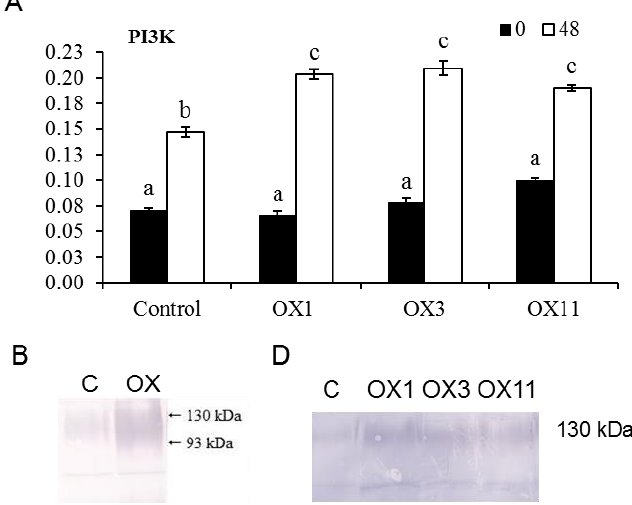
Figure 3. Panel A : Quantitative Realtime PCR analysis of transcript levels of phosphatidylinositol 3- 3-kinase in flowers (stage 5) of control (C) and transgenic PI3K (OX1, OX3 and OX11) N. tabacum lines. Detached tobacco flowers were stored for 48 h for analysis. Data represents mean ± SE from three biological replicates. Analysis of variance (ANOVA) was performed on data and significant ( p < 0.05) differences between means were determined using Duncan test. Statistical significance among means is denoted by different letters (a–c). Panel B : Immunoblot analysis of PI3K protein using antibodies against PI3K in control (C), and transgenic PI3K overexpressing (OX) N. tabacum floral tissues. The broad band represents a combination of native PI3K (~93 kDa), and PI3K-GFP (~130 kDa). Panel D : Immunoblot analysis performed with antibodies against GFP. Total proteins were isolated from flowers of control and transgenic PI3K (OX1, OX 3 and OX11) tobacco lines and immunoblot analysis was carried out with antibodies against